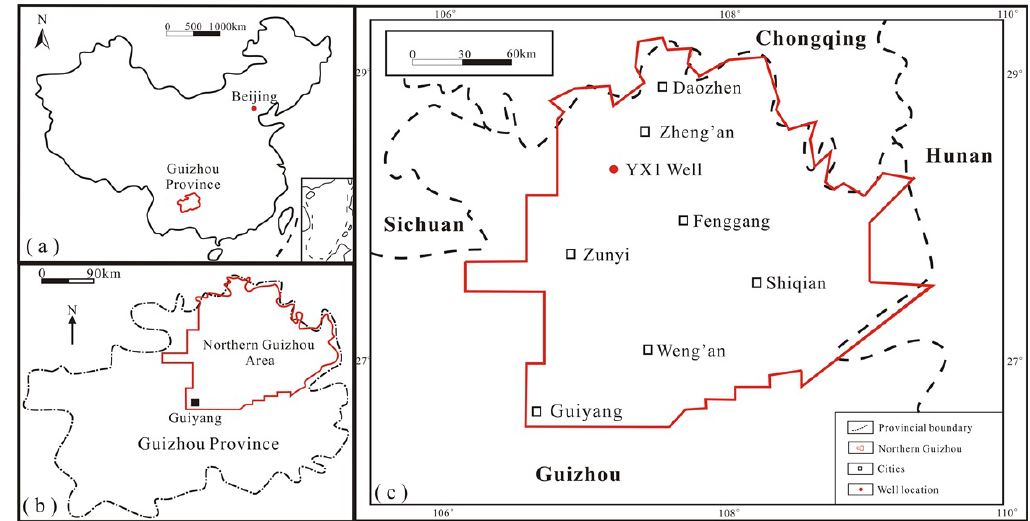
Figure 1. ( a ) Location of Guizhou Province; ( b ) location of Northern Guizhou area; ( c ) location of the study area and well location (Modified from Reference [34]).